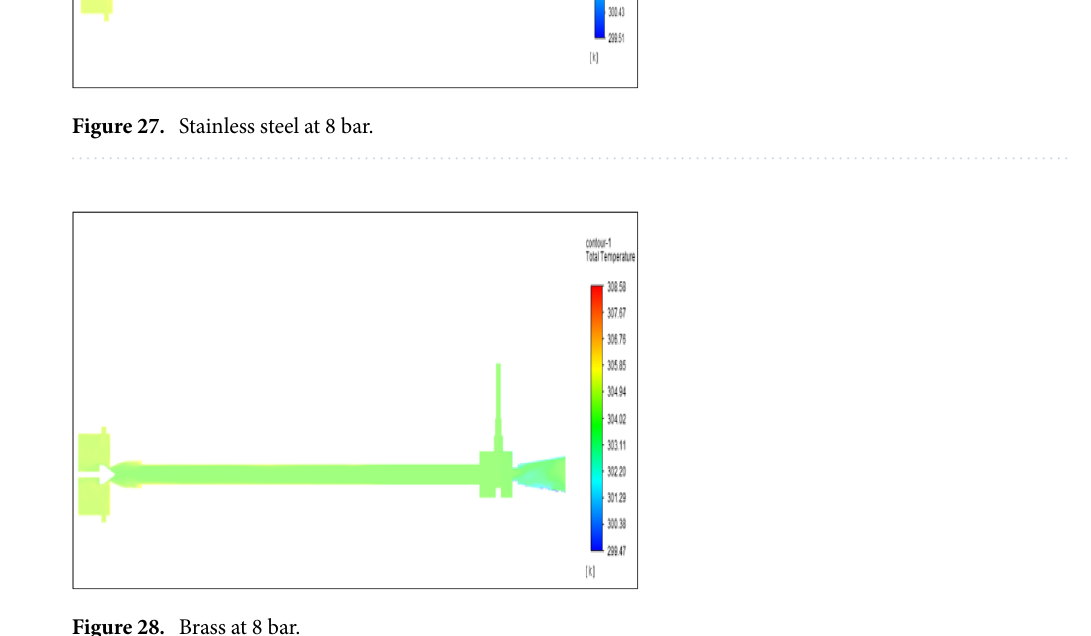
Figure 28. Brass at 8